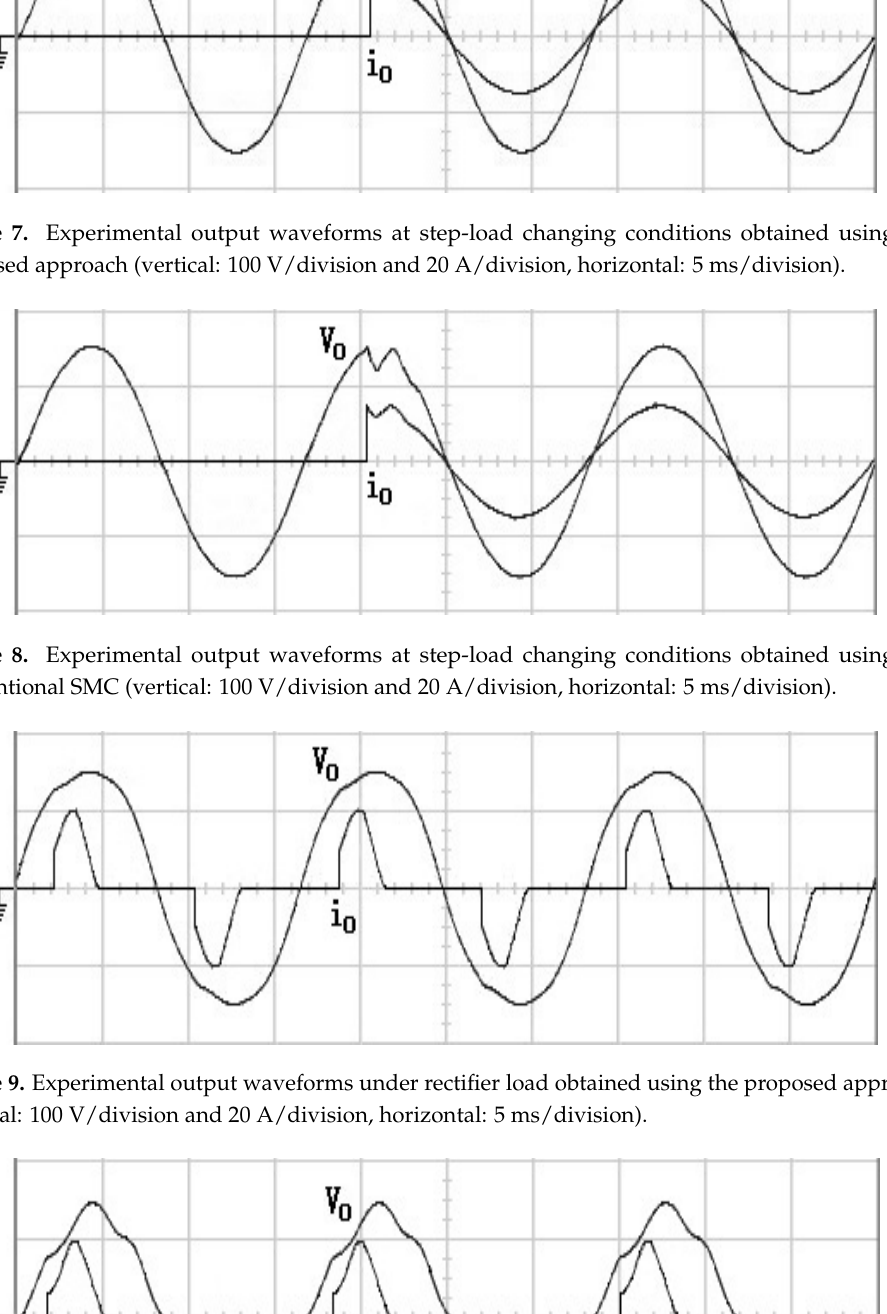
Figure 7. Experimental output waveforms at step-load changing conditions obtained using the